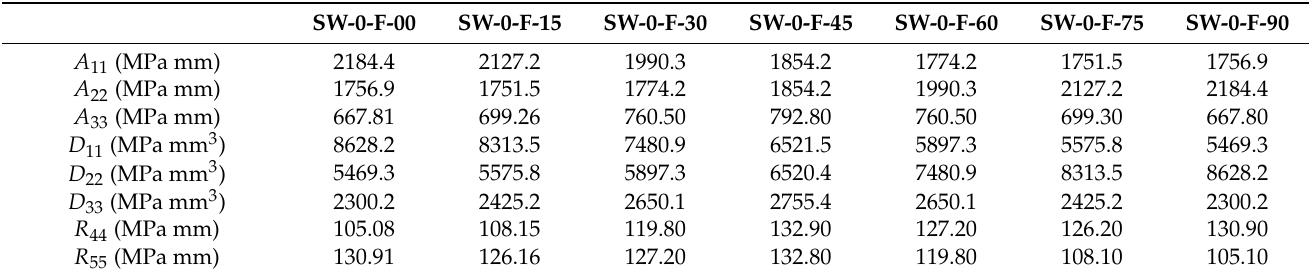
Table 6. Selected stiffnesses in SW samples with no perforation and with different flute orientations.